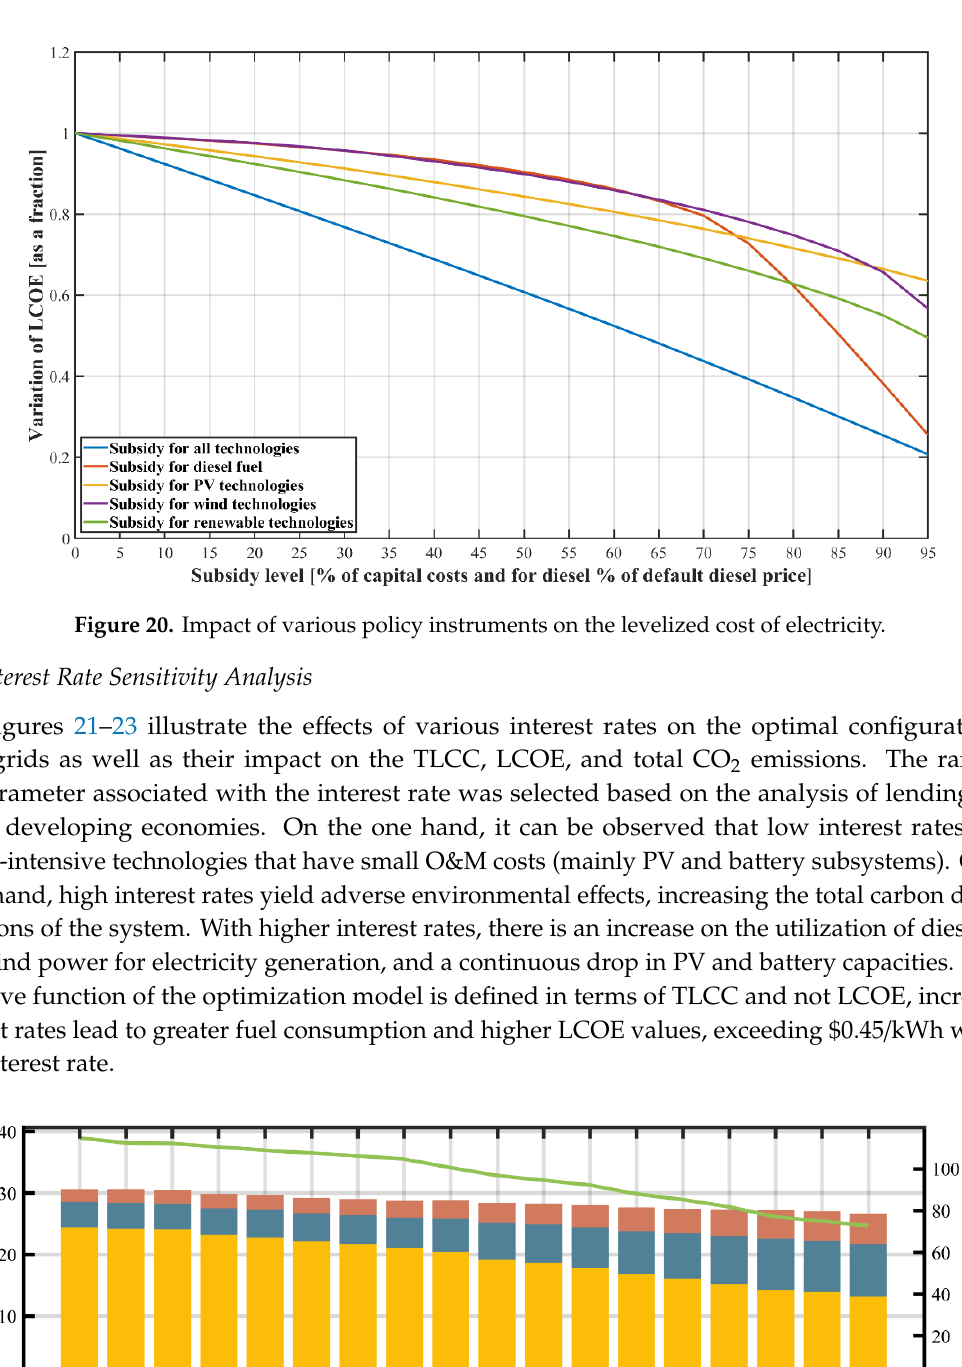
Figure 22. Simulation results of interest rate variation. Impact on LCOE and TLCC. Figure 23. Simulation results of interest rate variation. Impact on CO 2 emissions.